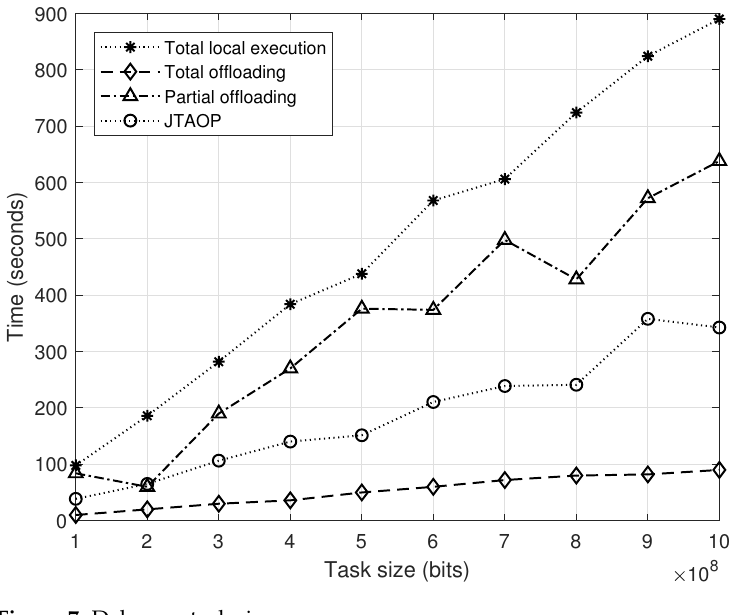
Figure 7. Delay vs. task size.